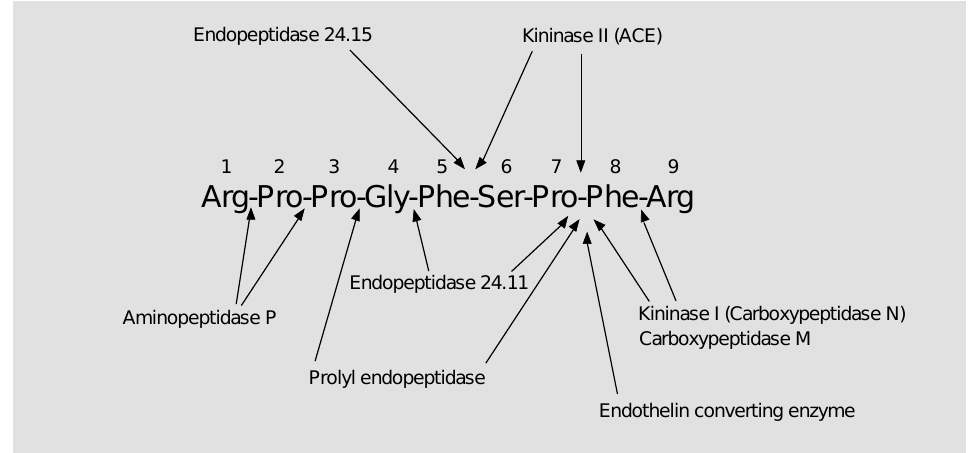
Figure 3 - Metabolism of kinin peptides. Some of the en- zymes that metabolize kinin peptides are shown with their sites of cleavage of the kinin molecule. ACE, Angiotensin converting